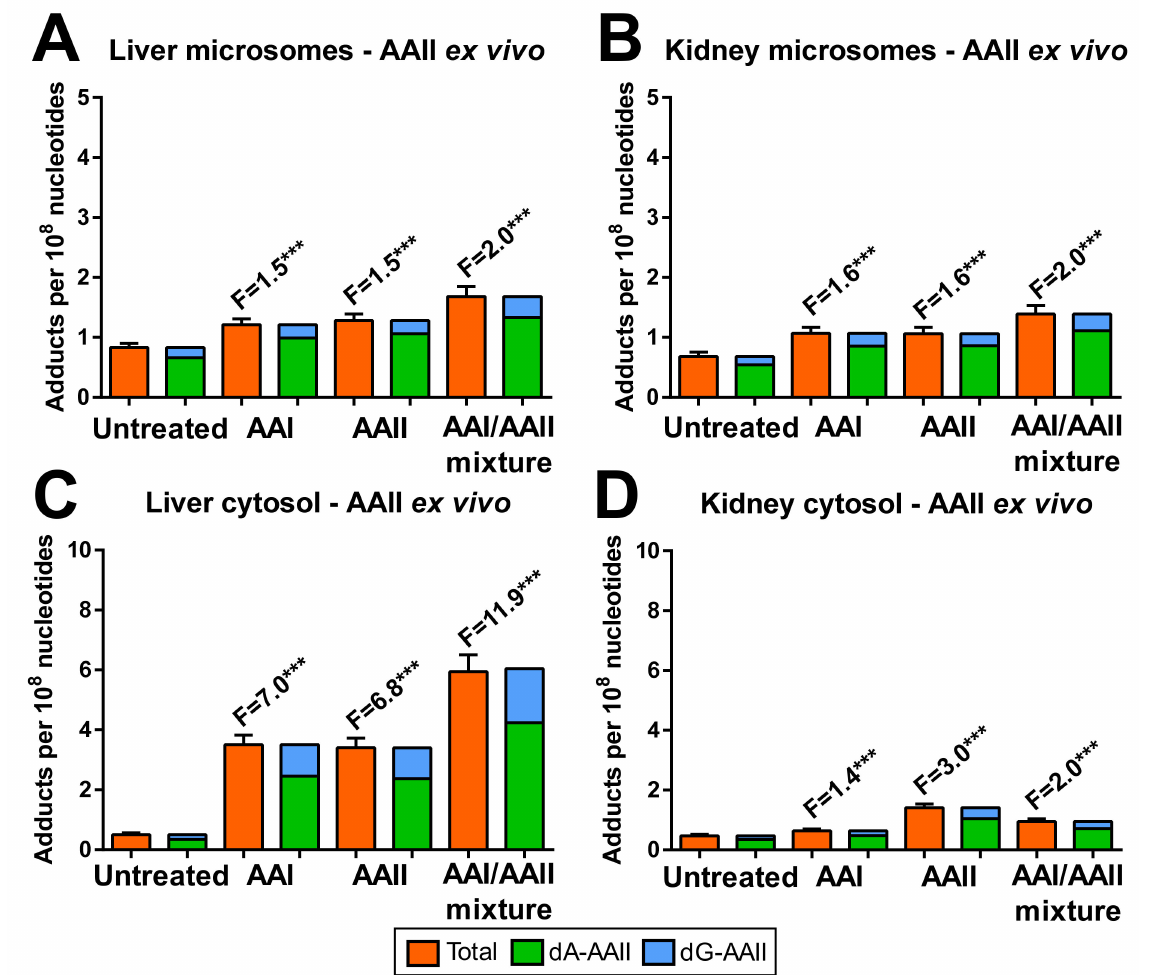
Figure 6. DNA adduct formation ex vivo by AAII in rat microsomal fractions of livers ( A ) and kidneys ( B ) from control (untreated) and rats pre-treated with AAI, AAII or AAI/AAII mixture, as determined by 32 P-postlabelling. DNA adduct formation ex vivo by AAII in rat cytosolic fractions of livers ( C ) and kidneys ( D ) from control (untreated) and rats pre-treated with AAI, AAII or AAI/AAII mixture, as determined by 32 P-postlabelling. All values are given as the means ± SD ( n = 3). Numbers above columns (‘F’) indicate fold changes in DNA adduct levels compared to control (untreated). Comparison was performed by t -test analysis: *** p < 0.001, differences from control (untreated). Note: Different scaling was used when comparing AA-DNA adduct levels in microsomal and cytosolic fractions. Negative control incubations were performed either ( i ) without cytosol or microsomes, ( ii ) without NADPH, ( iii ) without DNA or ( iv ) without AAI and were devoid of DNA